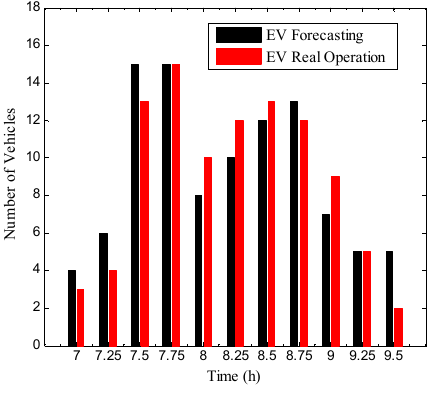
Figure 7. Forecasting and real data of the EVs’ arriving